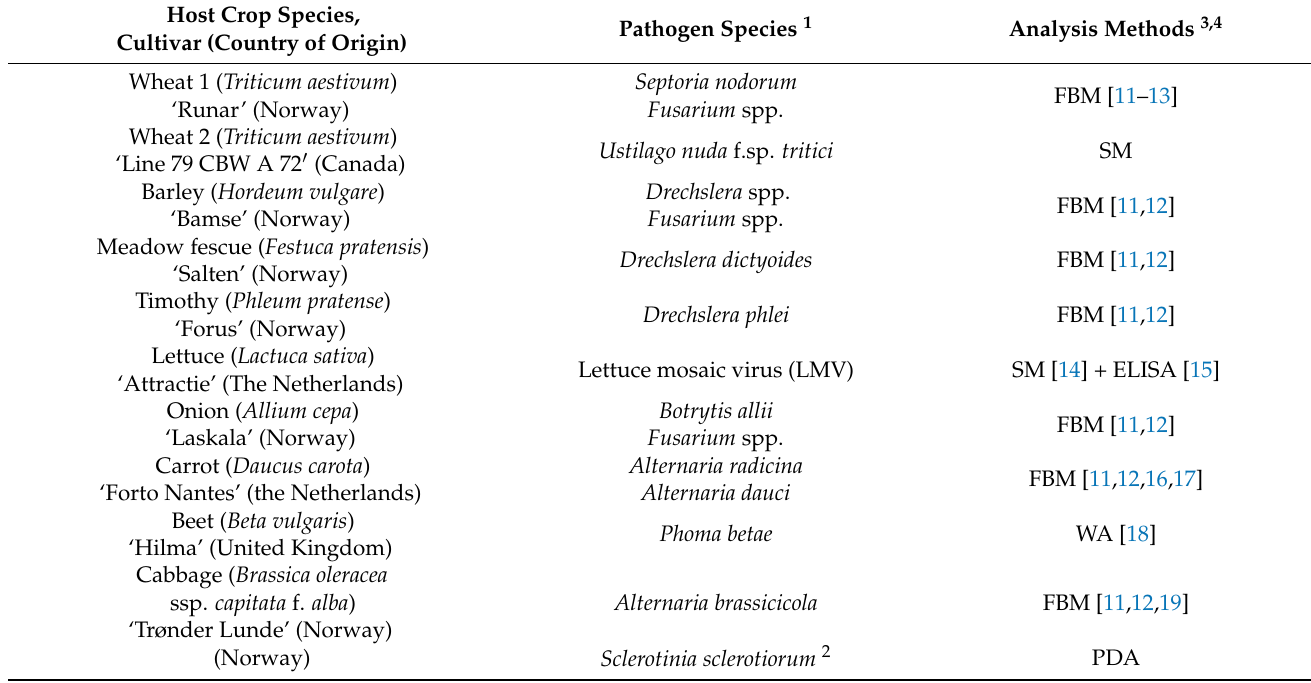
Table 1. Host crop species, cultivars (and country of origin), pathogen species studied, and the analysis methods used in the 100-year seed storage